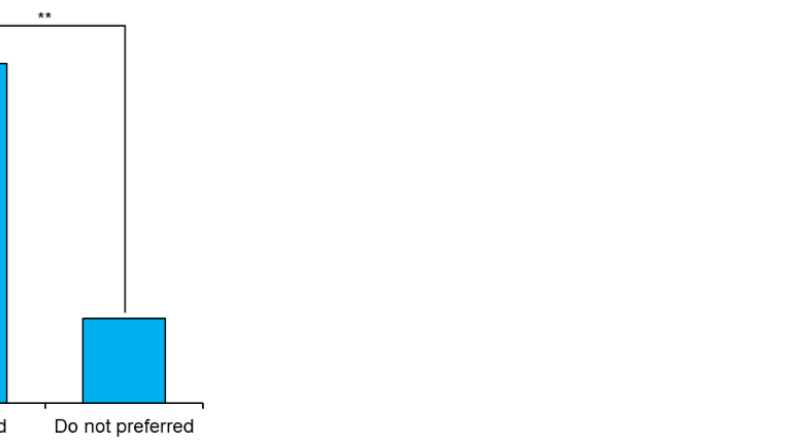
Figure 2. Experts’ percentage that considered public preferences in the organ allocation process (** p < 0.01). Table 5. Expert’s estimations about the general public perspectives.